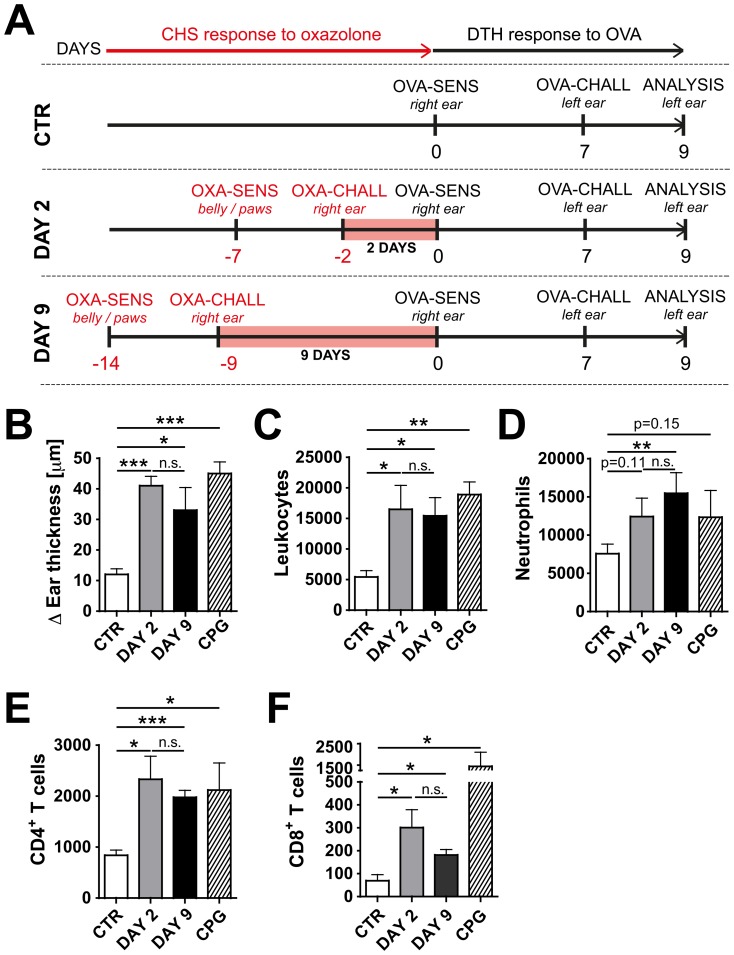
Skin inflammation enhances the induction of a DTH response to OVA in K14-VEGF-A-tg mice.(A) Schematic representation of the experiment: K14-VEGF-A-tg mice were grouped into a control (CTR) group, a DAY 2 and a DAY 9 group. On day -14 and day -7, mice from the DAY 9 group or the DAY 2 group, respectively, were sensitized by application of oxazolone (OXA) onto the belly and paws (indicated as OXA-SENS). 5 days later (day -9 or day -2), a CHS response was induced by challenging mice with oxazolone on the right ear (indicated as OXA-CHALL). On day 0, corresponding to 2 days (DAY 2 group) or 9 days (DAY 9 group) after the onset of inflammation (marked as a red bar), a DTH experiment was initiated in mice from all treatment groups. To this end, all mice were immunized by OVA injection into the CHS-inflamed or control right ear (indicated as OVA-SENS). On day 7, a DTH response to OVA was induced by OVA injection into the left ear (indicated as OVA-CHALL). The strength of the immune response in the left ear was analyzed two days later (day 9). (B) The ear swelling response in the left ear was significantly stronger in mice that had been immunized by OVA injection into the inflamed, right ear. The Δ ear thickness is shown, defined as the difference between the ear thickness measured at baseline and the ear thickness measured two days after DTH induction. CPG group: As a positive control group, some untreated control mice were immunized by injection of OVA plus CpG into their uninflamed right ears (R) on day 0, followed by a regular OVA challenge into the left ear (L) on day 7 (as described in 2A). (C–F) FACS analysis was performed on single-cell suspensions of the DTH-challenged left ear (L) to quantify leukocyte infiltration. Quantification of (C) total leukocytes (CD45+), (D) neutrophils (CD11b+.Gr1+), (E) CD4+CD3+CD45+ T cells and (F) CD8+CD3+CD45+ T cells. Representative data from 1 out of 3 similar experiments (n = 5 mice/group) are shown. *p<0.05; **p<0.01; ***p<0.001.